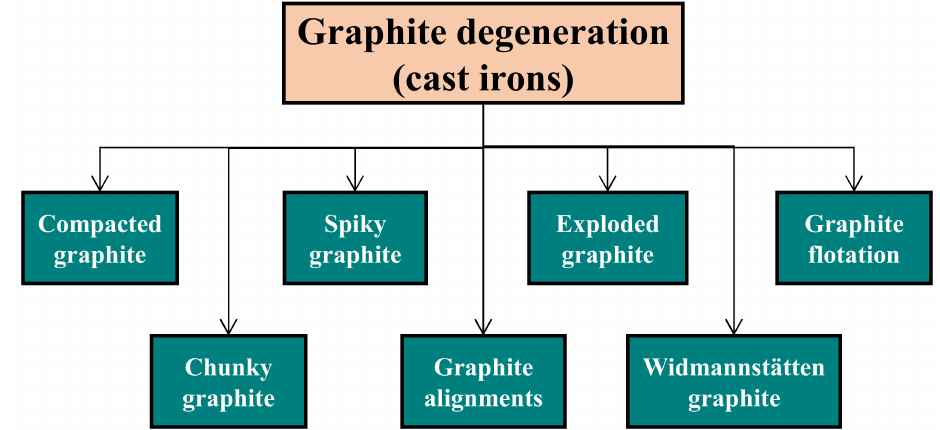
Figure 76. Various forms of degenerate graphite in ductile iron castings.